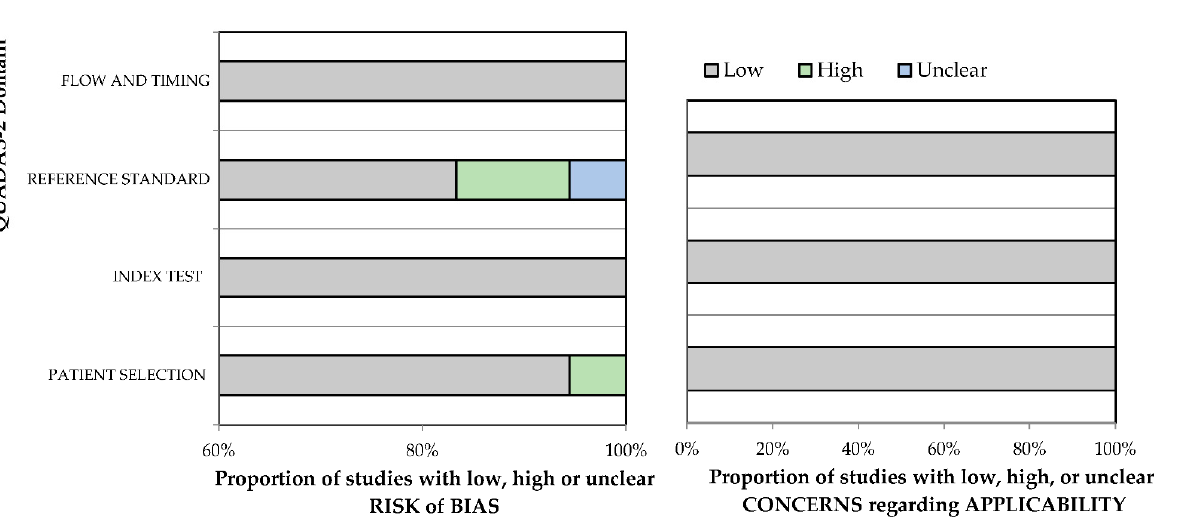
Figure 2. QUADAS-2 assessment of the individual risk of bias domains and applicability